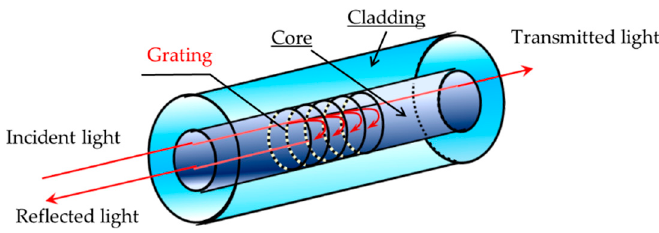
Figure 1. Schematic view of the sensor (fiber Bragg grating).